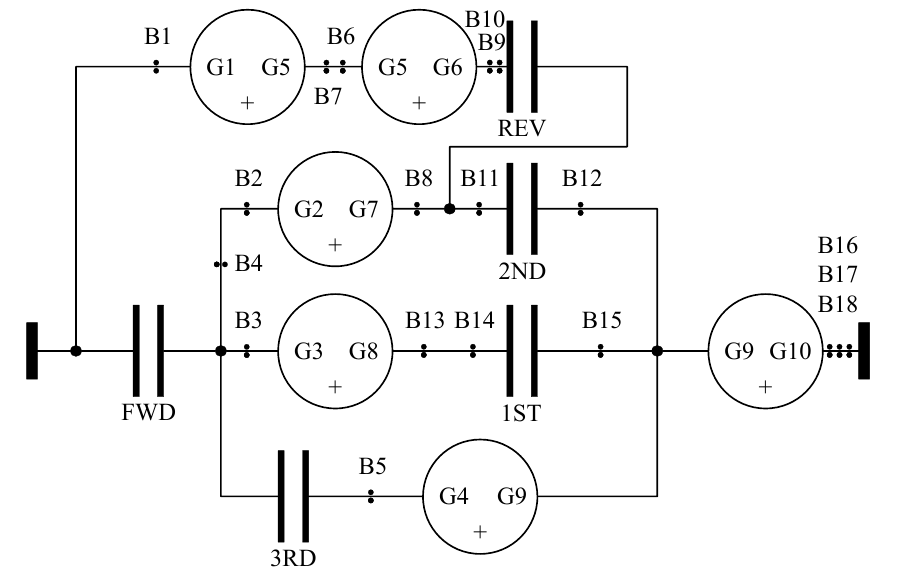
Figure 9: Torque plan